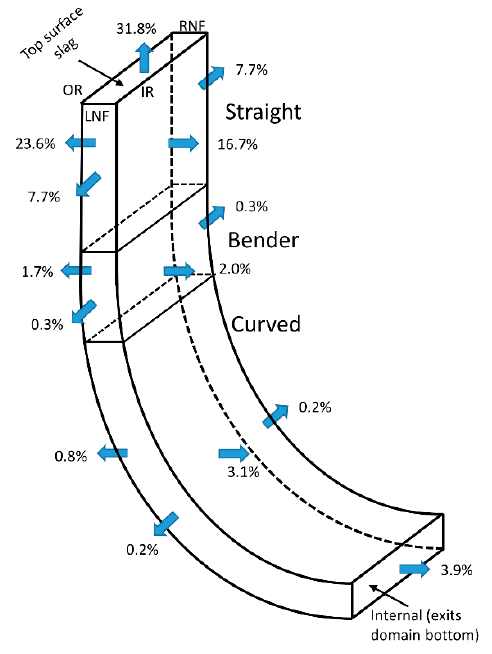
Metals 2021 , 11 , 654 Figure 16. Fractions of inclusions captured in different strand regions. Figure 16. Fractions of inclusions captured in different strand regions.